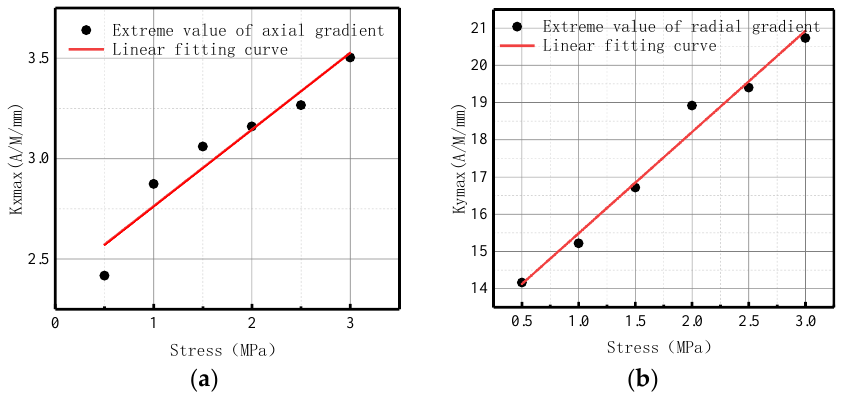
Figure 20. Kmax variations at base metal crack with internal pressures. ( a ) Axial component of Kmax ; ( b ) radial component of Kmax .